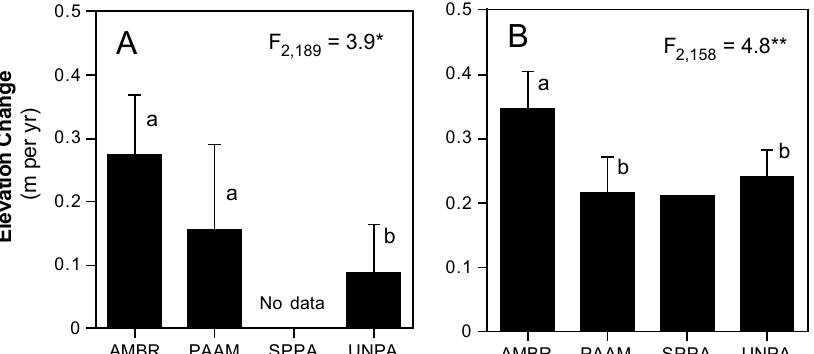
Figure 8. Comparisons (mean ± 95% CI) of changes in sand elevation (m per year) in the field for ( A ) all values (sand accretion and erosion) and ( B ) only positive values (sand accretion) for quadrats with monocultures of the four dune grass species (abbreviations in Figure 4). One-factor ANOVA results are given in the plots. Bars that do not share letters are significantly different (Tukey’s HSD p ≤ 0.05). SPPA values in (B) are based on two values (0.22, 0.21) and were not included in the ANOVA analyses. * p < 0.01, ** p < 0.001.